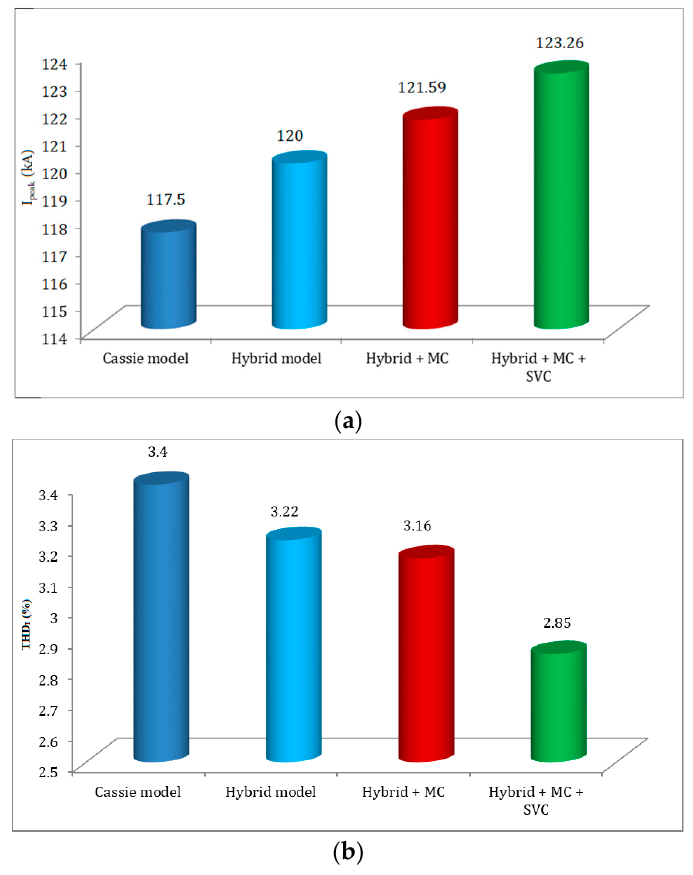
Figure 15. ( a ) I peak in kA ( b ) THD I (%).